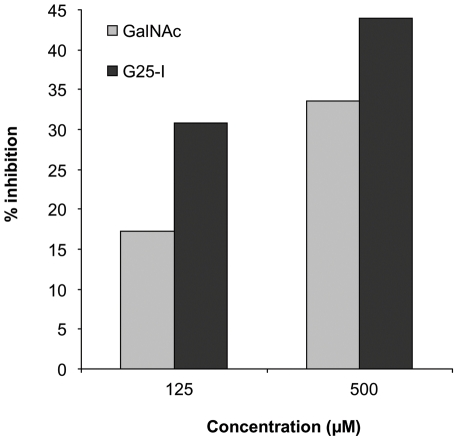
Binding of macrophage galactose-type lectin (MGL) to the galactosaminogalactan of A. fumigatus.ELISA-inhibition of MGL-Fc interacting with α-GalNAc-conjugated polyacrylamide (GalNAc-PAA) by free GalNAc monosaccharides and a mixture of oligosaccharides exclusively composed of N-acetylgalactosamine with an average degree of polymerisation of 7.5 (G25-I). ELISA plates were coated with GalNAc-PAA (2 µg/ml). Plates were blocked with 1% BSA and the recombinant MGL-Fc chimera was added (0.5 µg/ml) for 2 h at room temperature in the presence of 0.125 and 0.25 mM of SGG hydrolysate fractions (G25-I). Binding was detected using a peroxidase-labeled anti-human IgG-Fc antibody.